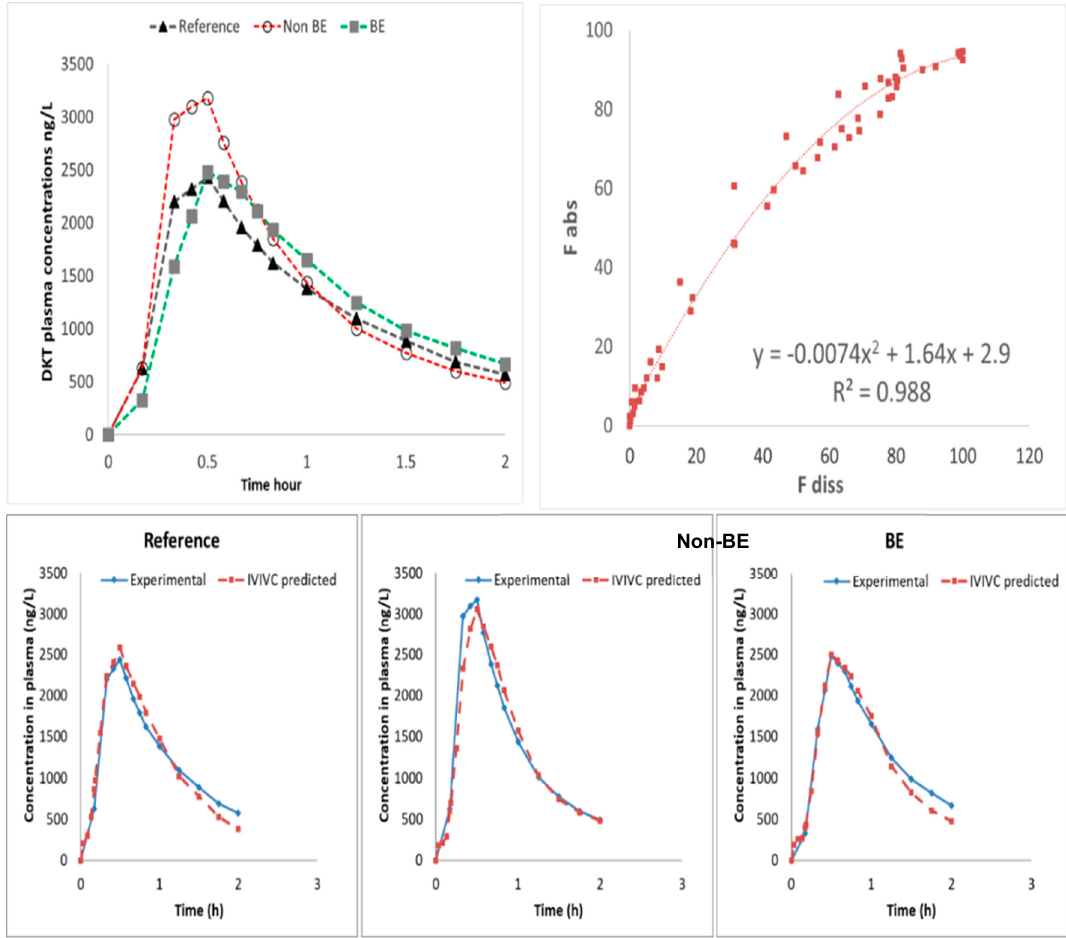
Figure 7. Invitro–invivo correlation (IVIVC) level A. ( Top left plot ) Human plasma levels of DKT after oral administration of the reference product (Enantyum ® ) and two test formulations from two BE trials. Concentrations of test products were normalized using the ratio of reference concentrations. Plasma levels are shown up to 2 h to highlight C max differences. ( Top right plot ) Non-linear IVIVC plotting fraction absorbed versus fraction dissolved. ( Bottom plots ) Internal validation through prediction of plasma levels for each formulation.